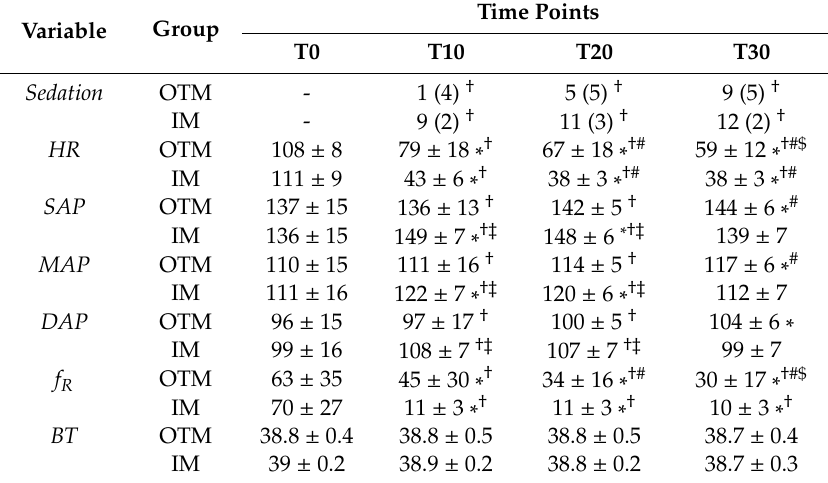
the table. HR: heart rate; SAP: systolic arterial blood pressure; MAP: mean arterial blood pressure; DAP: diastolic arterial blood pressure; f R: respiratory rate; BT: body rectal temperature.